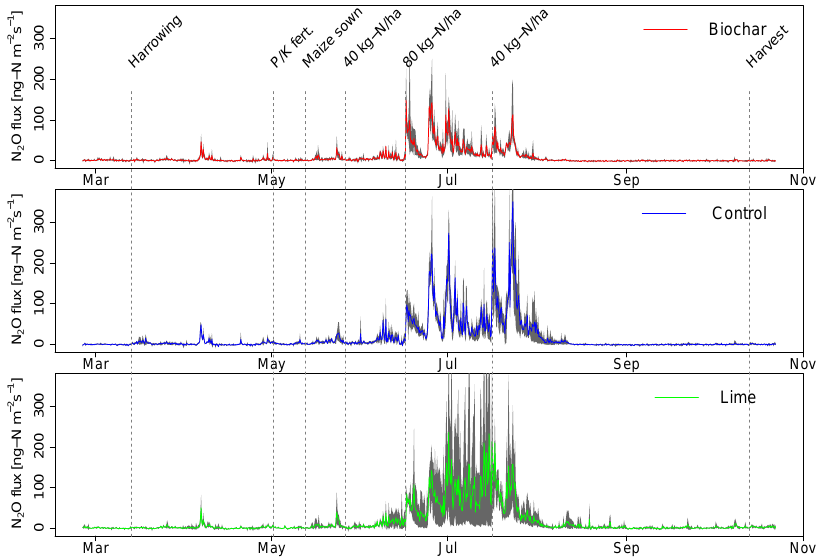
Figure 3. Mean N 2 O emissions for each treatment (coloured line) with highest and lowest replicate in grey.